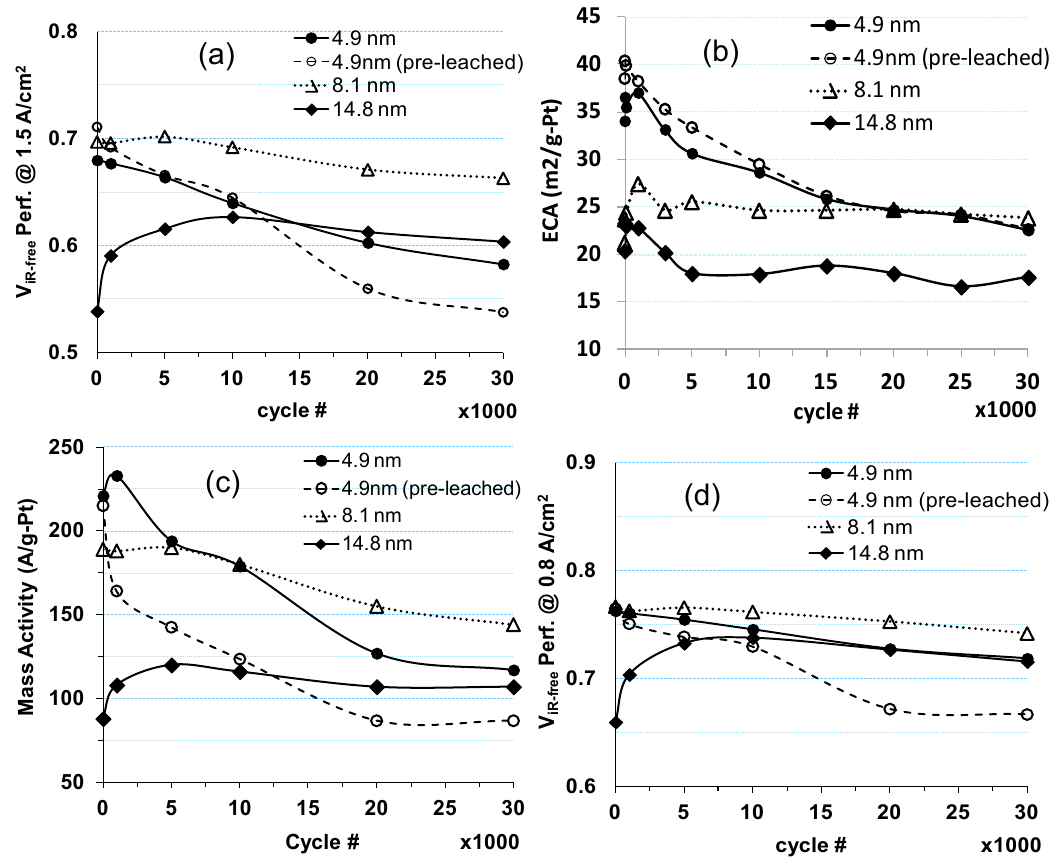
Figure 4. Performance decay with potential cycling for 4.9 nm, 8.1 nm, and 14.8 nm Pt 3 Co electrodes, ( a ) ECA, ( b ) Mass activity (A/g-Pt at 0.90 V), ( c ) H 2 /Air performance at 0.8 A/cm 2 and ( d ) H 2 /Air performance at 1.5 A/cm 2